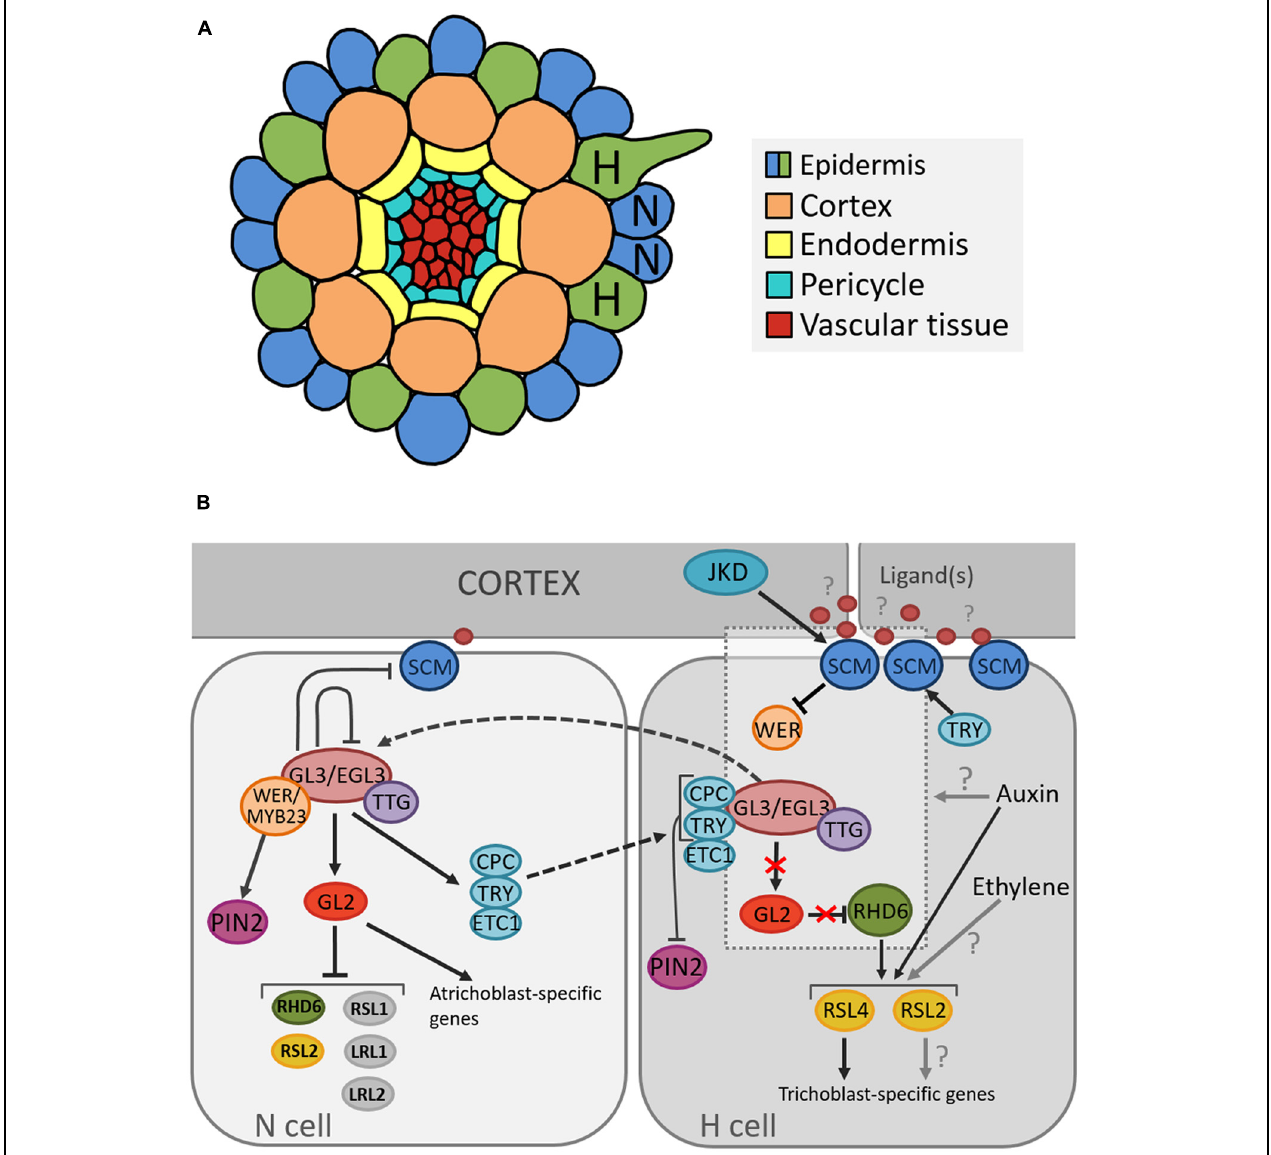
FIGURE 2 | Cellular organization of the Arabidopsis root and model for the position-dependent cell fate determination. (A) Schematic representation of the cellular organization on a transverse section through the Arabidopsis root depicting the position of root hair (H) and non-root hair (N) cells. (B) Model of molecular pathways determining root hair and non-root hair cell fate in the Arabidopsis epidermis. Arrows, blunted lines and broken lines are indicative of positive control, negative regulation, and intra/intercellular protein movement,